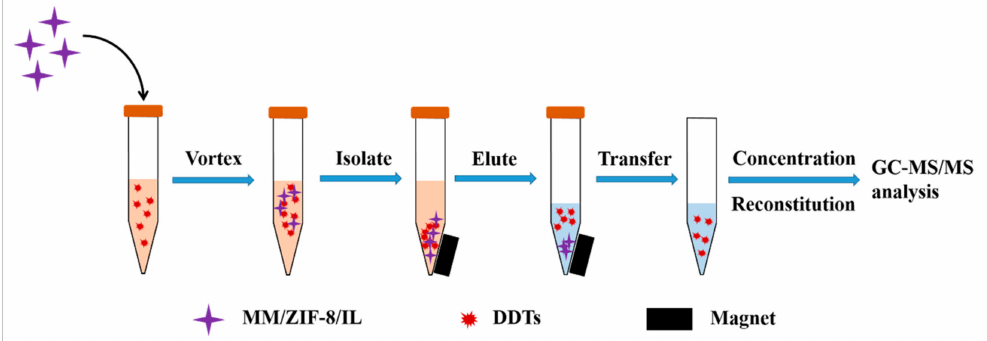
Figure 5. Typical procedure of the proposed magnetic solid-phase extraction (MSPE)